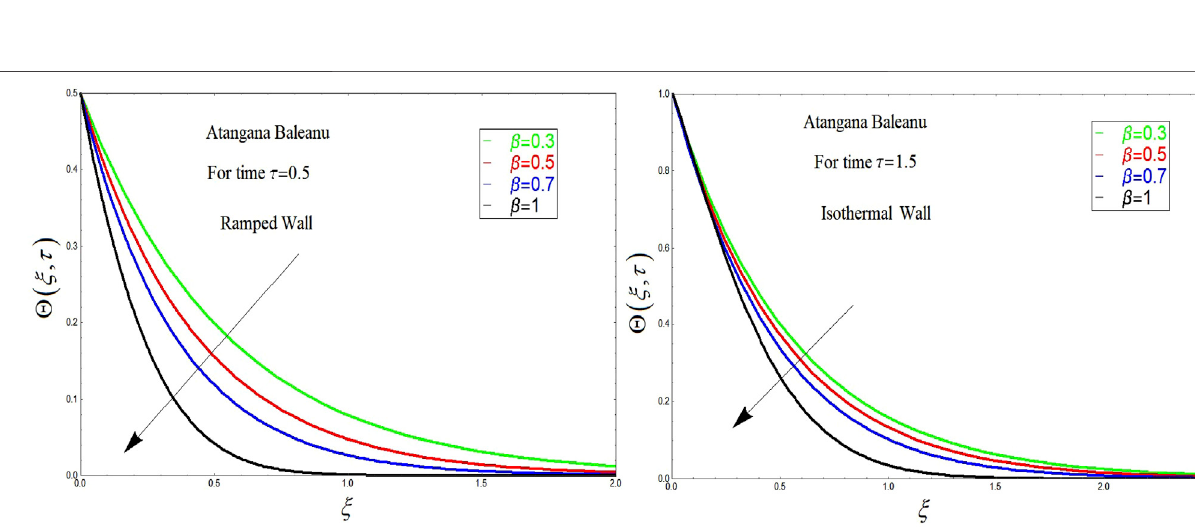
FIGURE 8 | Impact of the AB fractional operator on